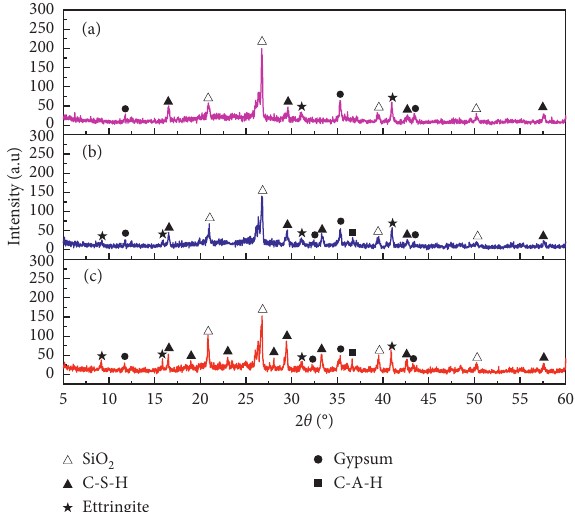
Figure 7: XRD patterns for CPB samples after curing at 40 ° C for 12 hours: (a) RM, (b) PC, and (c) SC.